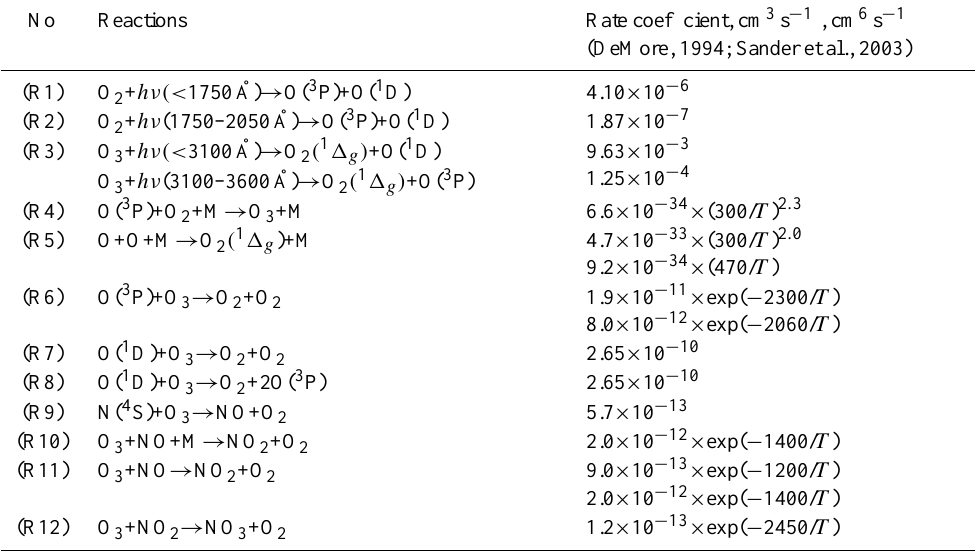
Table 1. Principal reactions for formation and destruction of odd oxygen.